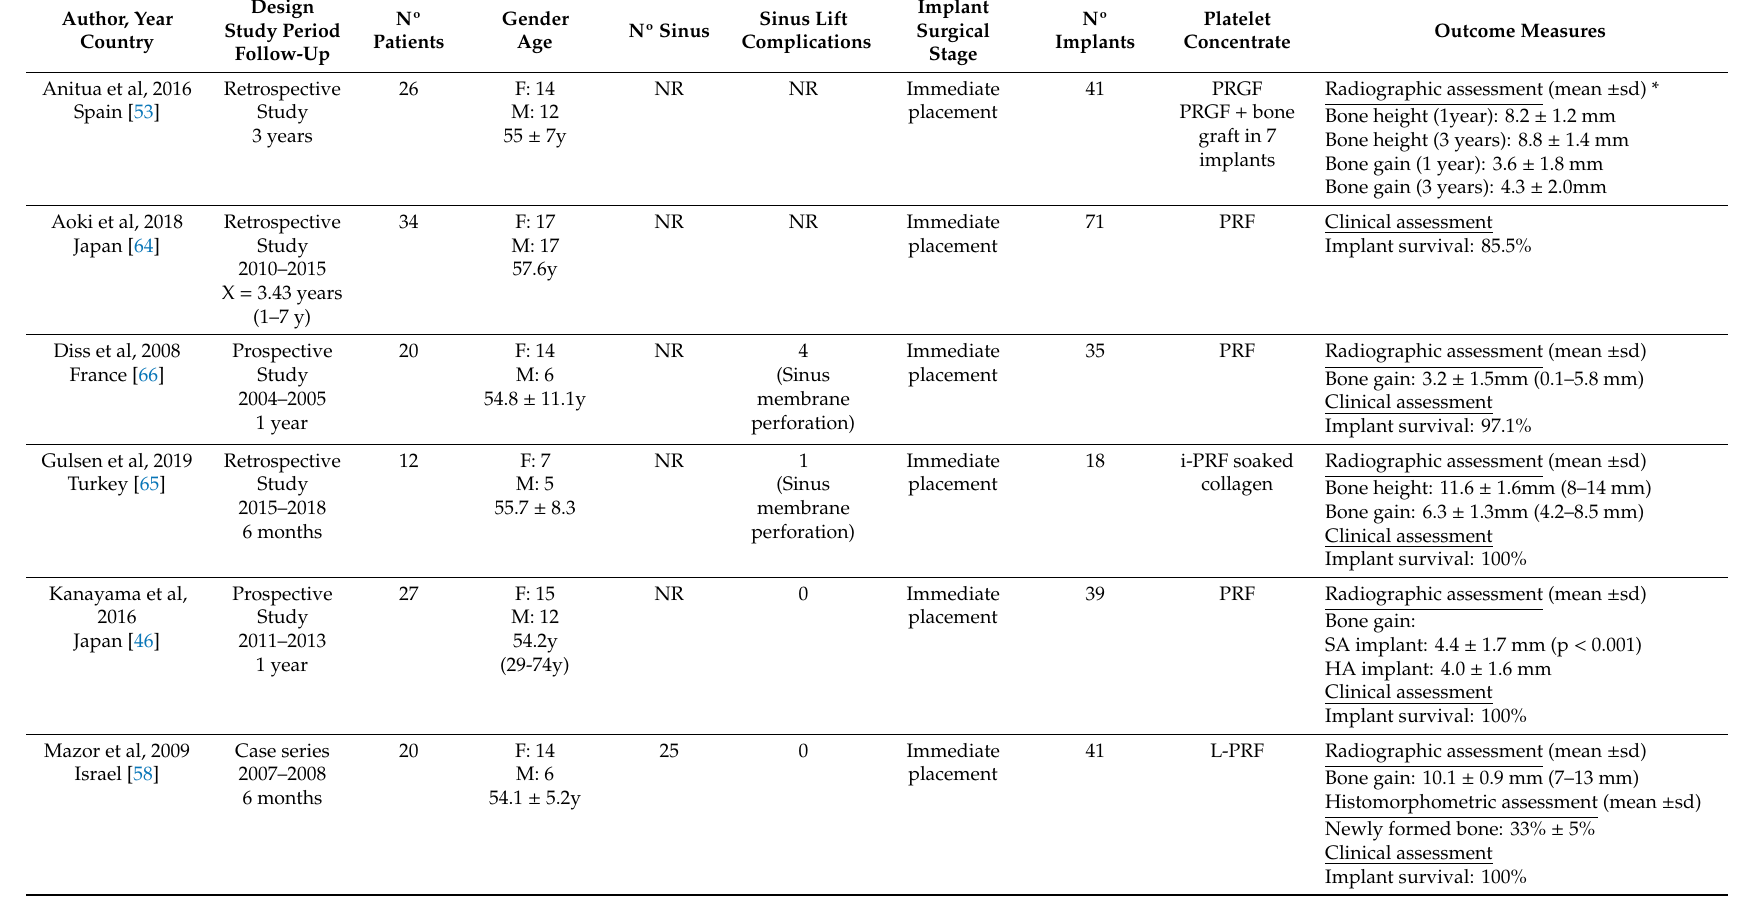
Table 1. Descriptive characteristics of studies included for sole use of platelet concentrates in sinus floor